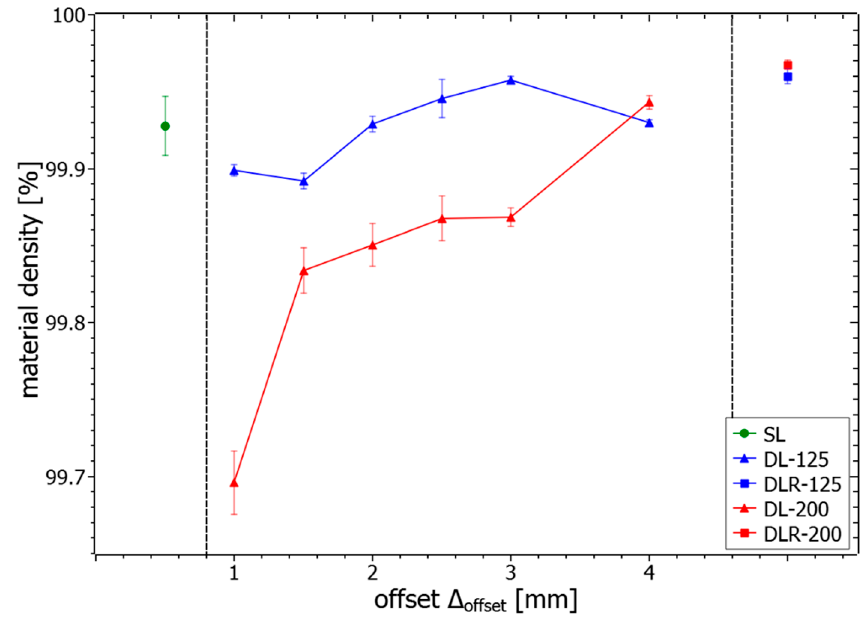
Figure 8. Measured material density values of the samples produced using the listed parameters.